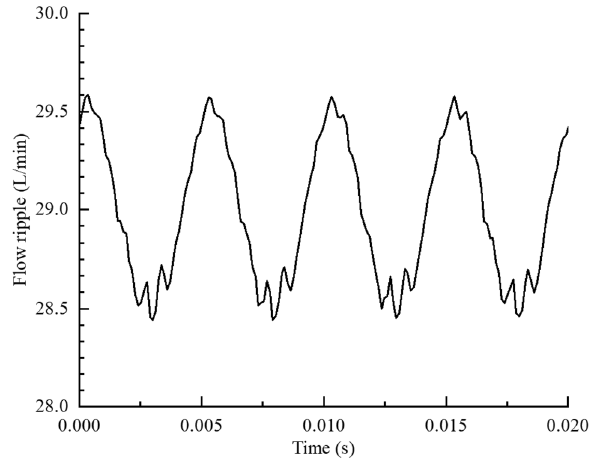
Figure 31. Time-domain curve of flow ripple ( n = 1200 r/min, P 0 = 5 MPa).